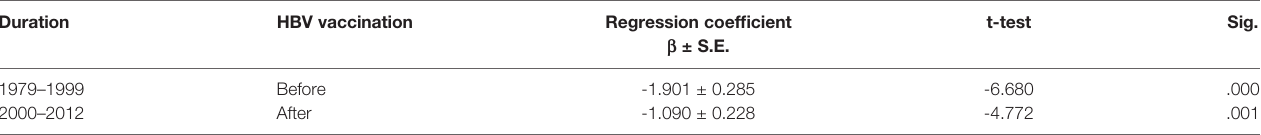
TABLE 2 | The trend of HCC incidences before and after HBV vaccination in Shanghai. Duration